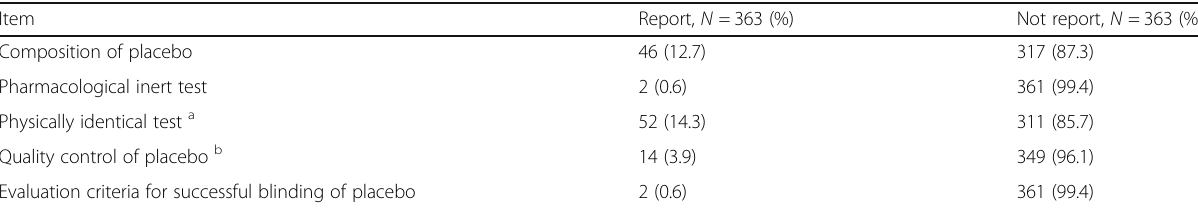
Table 2 Placebo characteristics in CHM trial registrations Item